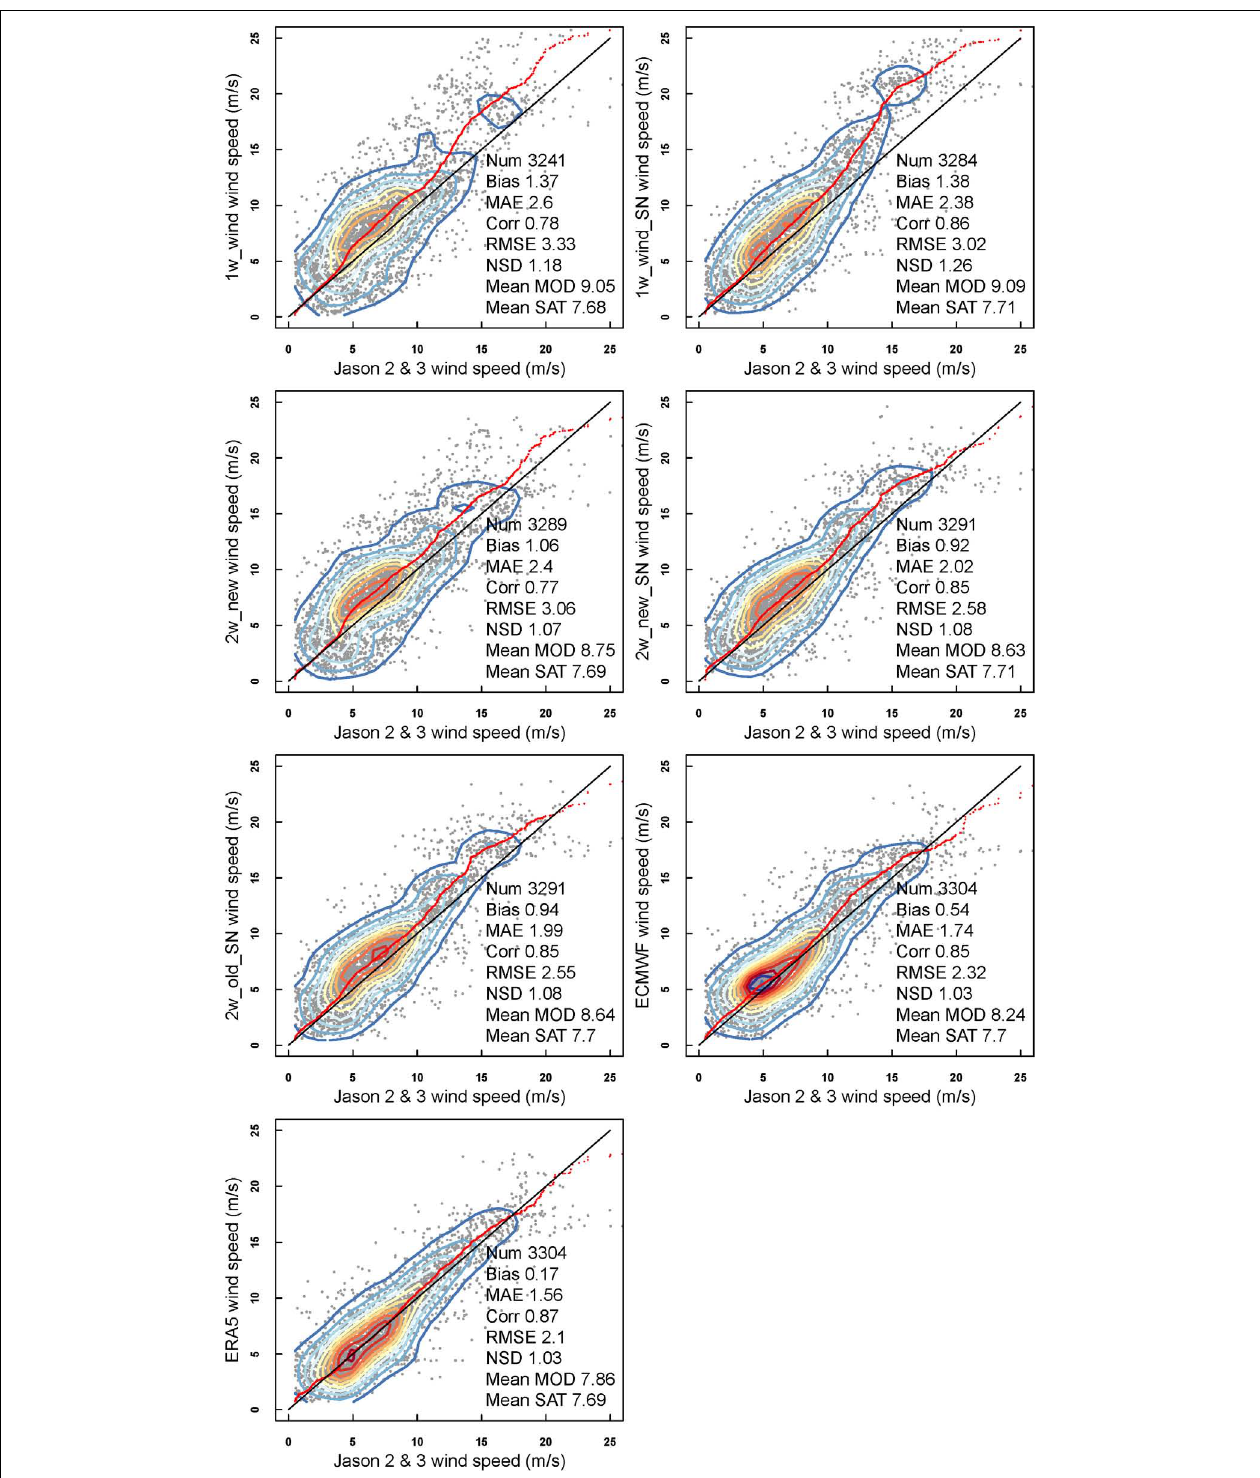
FIGURE 10 | Comparison of the modeled wind speed ( y -axis) with satellite wind observations ( x -axis): qq plots (red dots) and scatter plots (gray dots). The kernel density estimations (contour lines) are included.